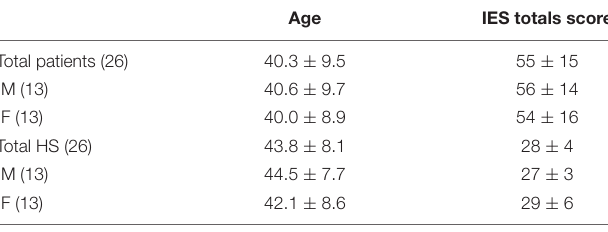
TABLE 1 | Demographic data of PTSD patients and healthy subjects (HS) (in the total sample and in the two sexes).